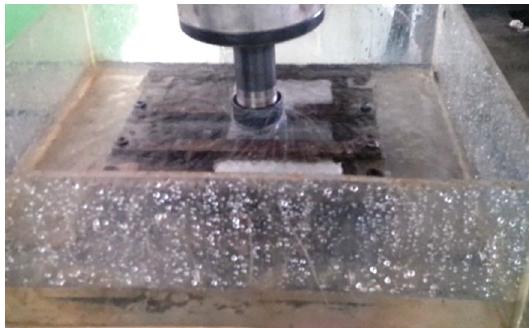
Figure 2 . Processing view of